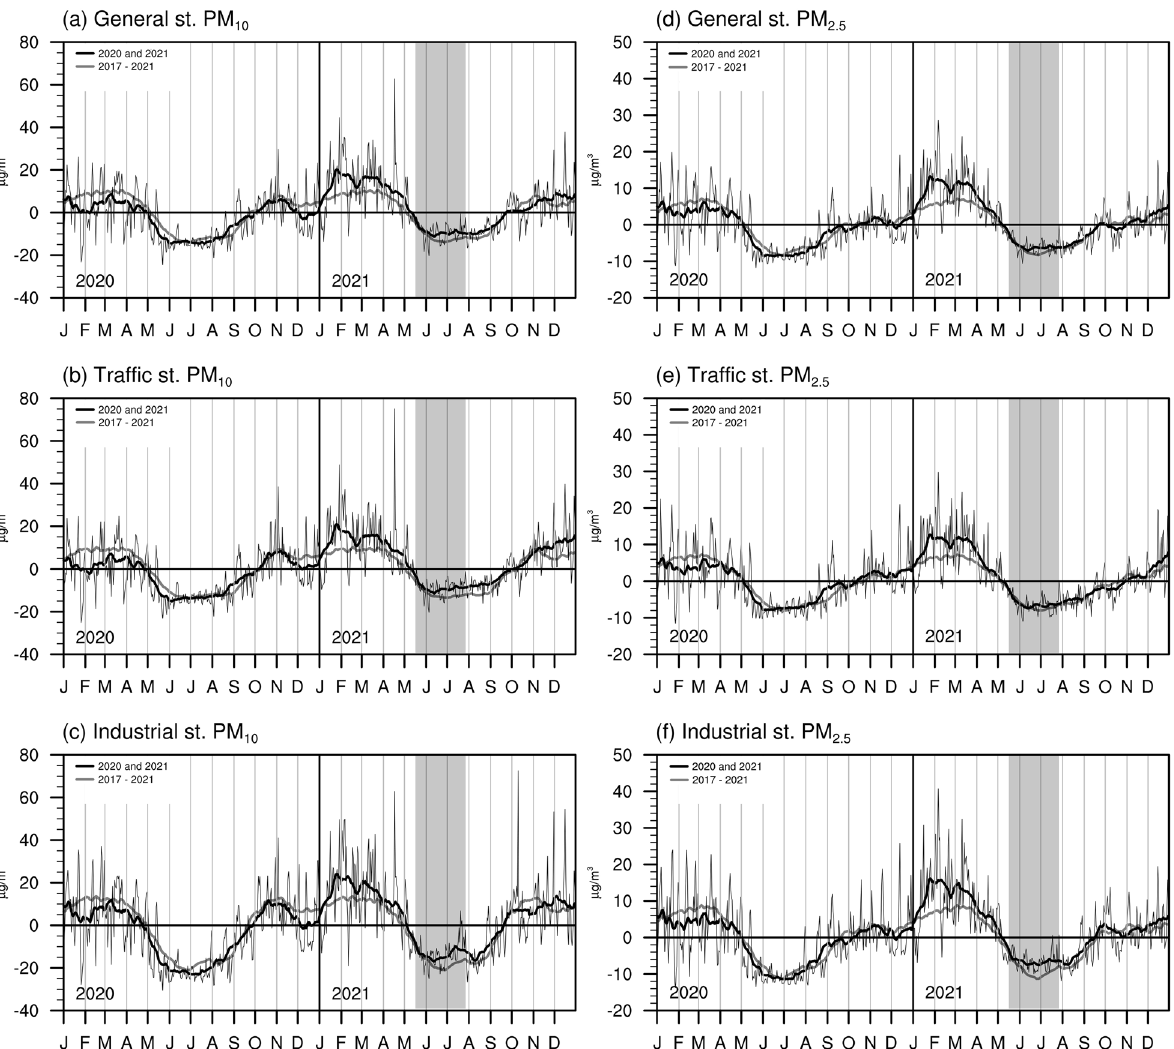
Fig. 9 The annual cycle of PM 10 concentration in 2020–2021 monitored by the ( a) general stations, ( b) traffic stations and c industrial stations. ( d–f) are same as ( a–c) but for PM 2.5 concentration. The daily values are shown in thin black line with 31‑day running mean in bold black line, and the 5‑year mean values (2017–2021) are shown in gray line. Shaded areas denote the period of the Level 3 alert. All the variations have performed detrending operations to remove long‑term change